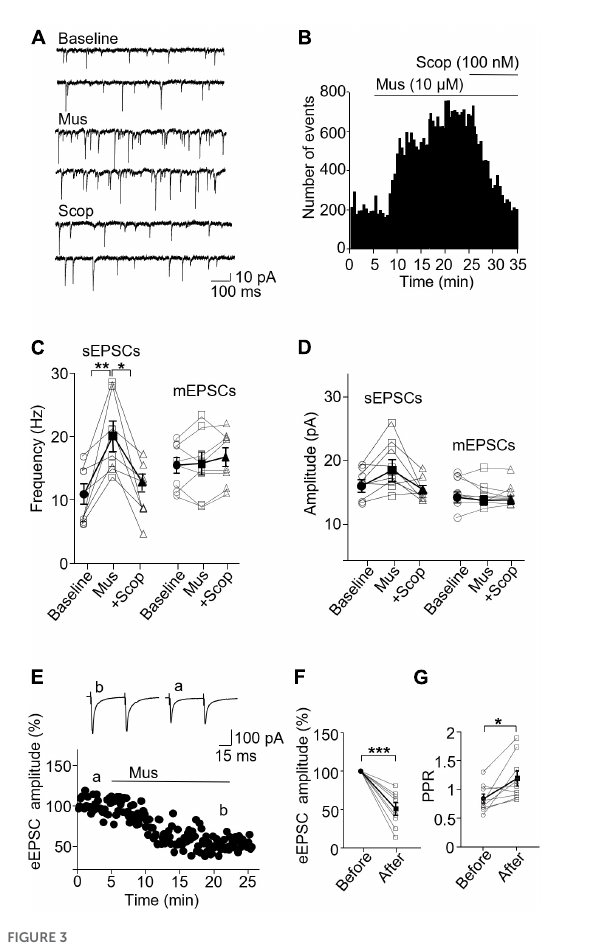
FIGURE3 Activation of mAChRs enhances spontaneous excitatory synaptic activity in PV interneurons in the ACC. (A) Representative traces of sEPSCs from a PV interneuron in the ACC before and after application of muscarine and scopolamine. (B) A histogram shows the effect of muscarine and scopolamine on sEPSC frequency in the PV interneuron. (C,D) Summarized data show the effect of muscarine on sEPSC ( n = 8 cells/6 mice) and mEPSC ( n = 8 cells/5 mice) frequency and the amplitude. (E) A representative experiment shows the effect of muscarine on evoked EPSCs. Insets: evoked EPSCs traces taken at the times marked by a and b in the graph. (F,G) Summarized data show the effect of muscarine on evoked EPSC ( n = 8 cells/5 mice) amplitude and paired-pulse ratio, respectively. * p < 0.05, ** p < 0.01, and *** p <